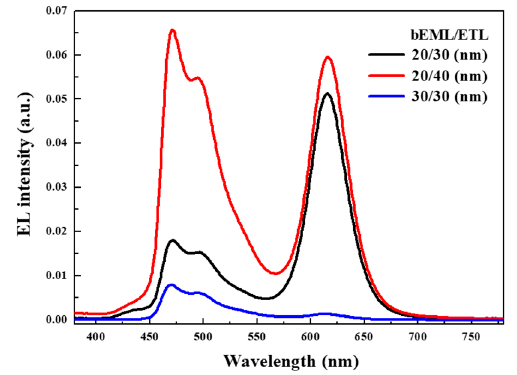
Figure 6. EL spectra of QLEDs with various thicknesses of blue emission layer (bEML) and electron transport layer (ETL) at 10.5 V.